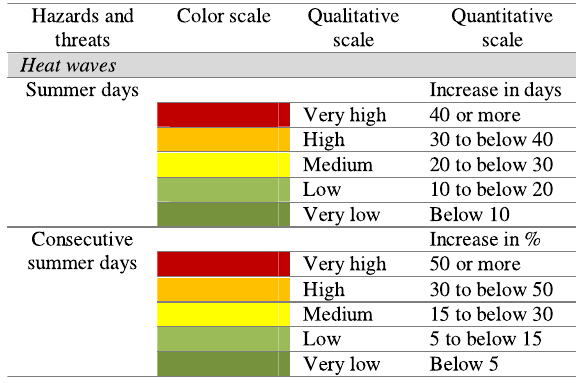
Table 5 Classification of the quantitative scale for the heat wave indices shown in Table